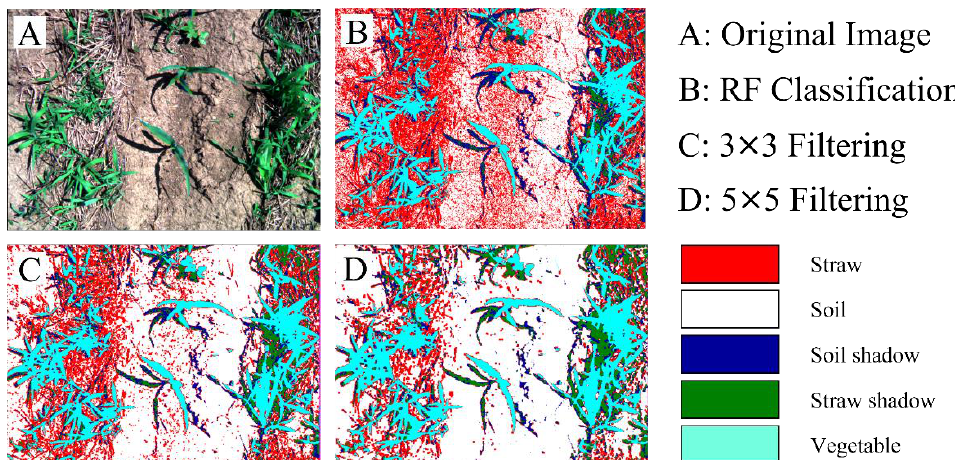
Figure 4. Comparison of sample points before and after classification. Note: In the figure, ( A ), ( B ), ( C ) and ( D ), respectively, represent the original sample image, RF classification image, 3 × 3 salt and pepper filtering processing and 5 × 5 filtering processing after RF classification.